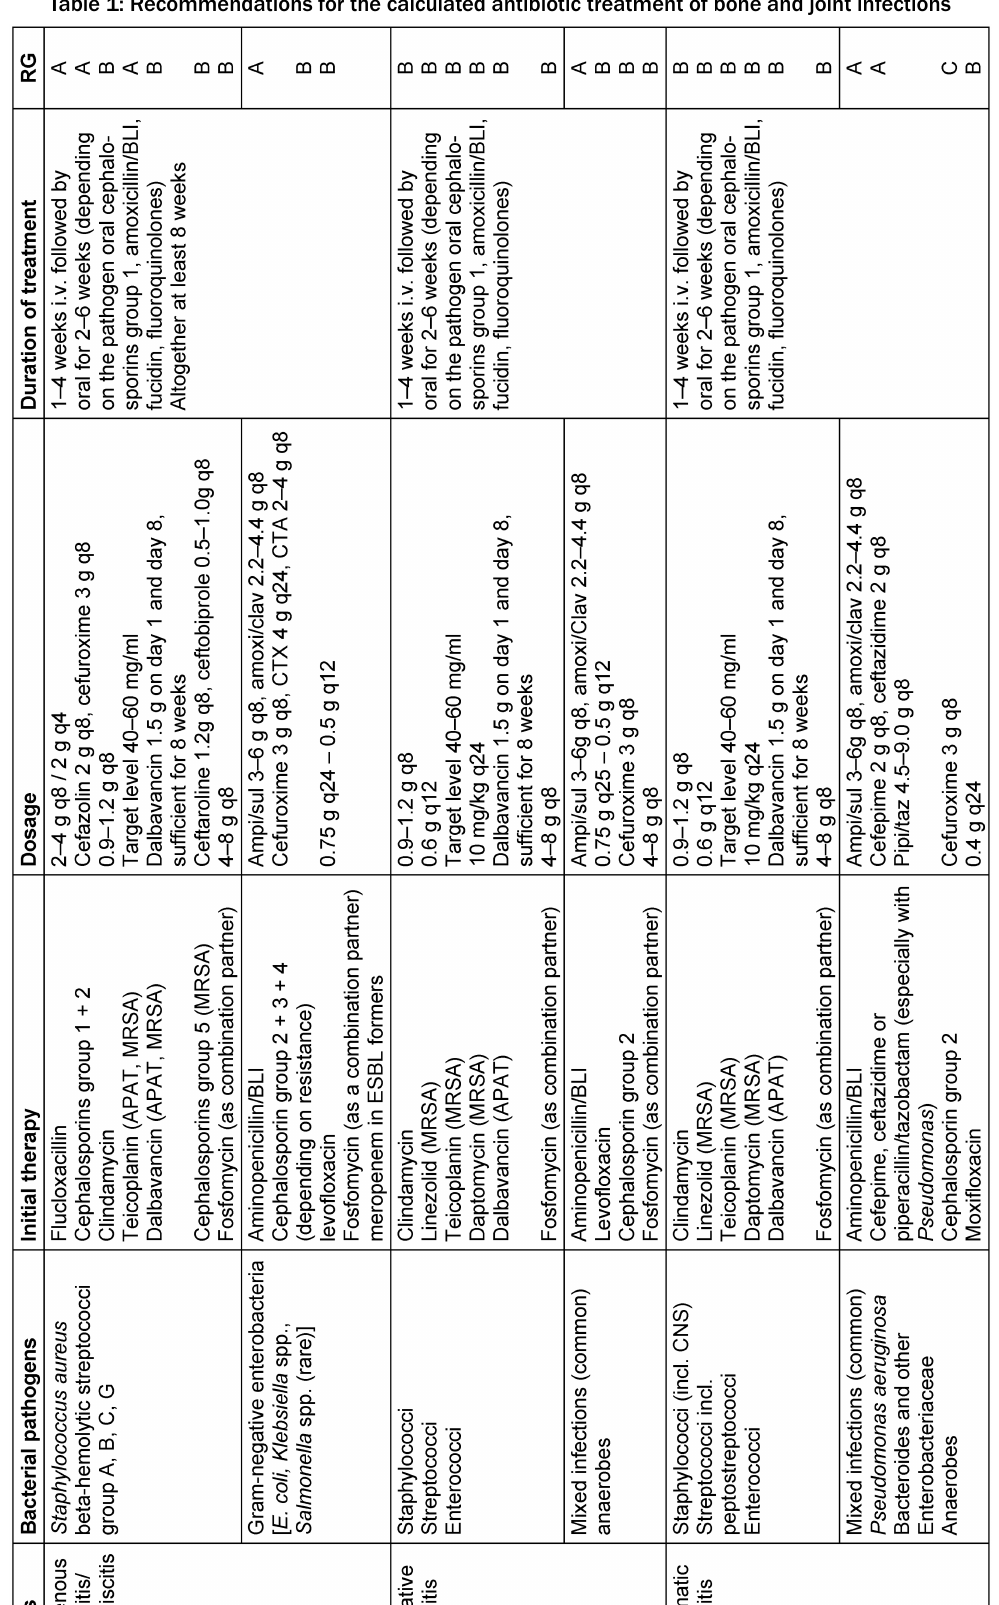
Table 1: Recommendations for the calculated antibiotic treatment of bone and joint